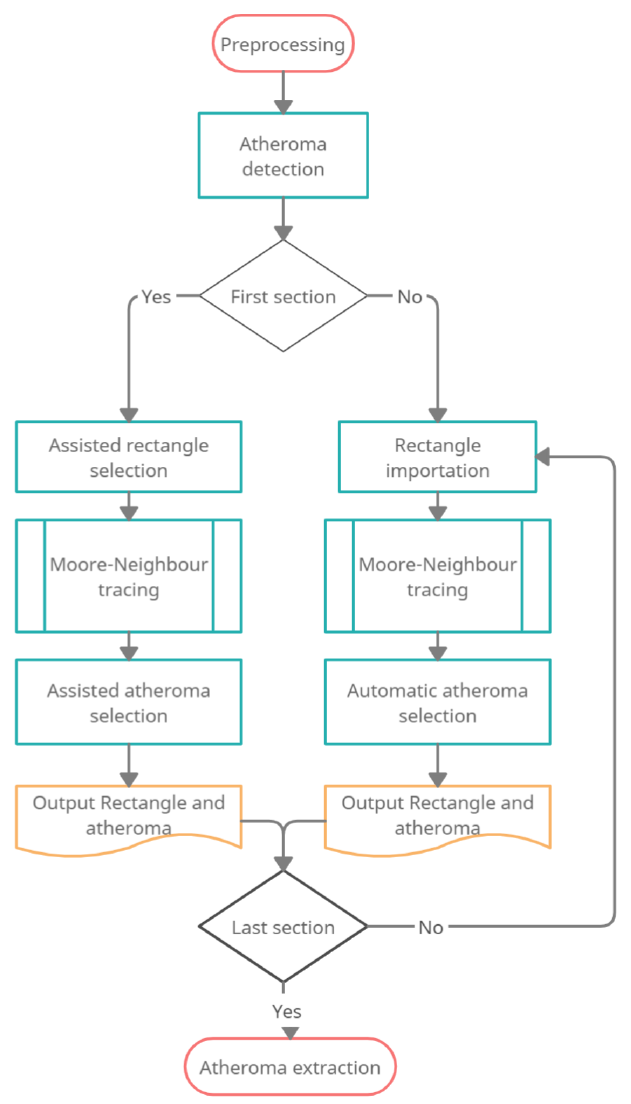
Figure 3. Flowchart of the atheroma detection